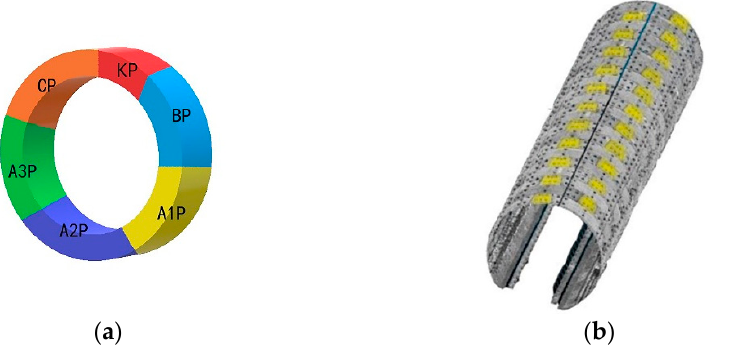
Figure 7. ( a ) Schematic segmentation diagram. ( b ) Capping block (KP) position in point cloud.